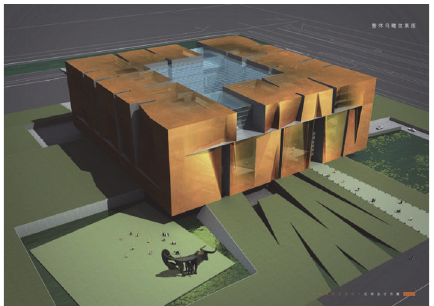
Figure 1: Architectural rendering of museum